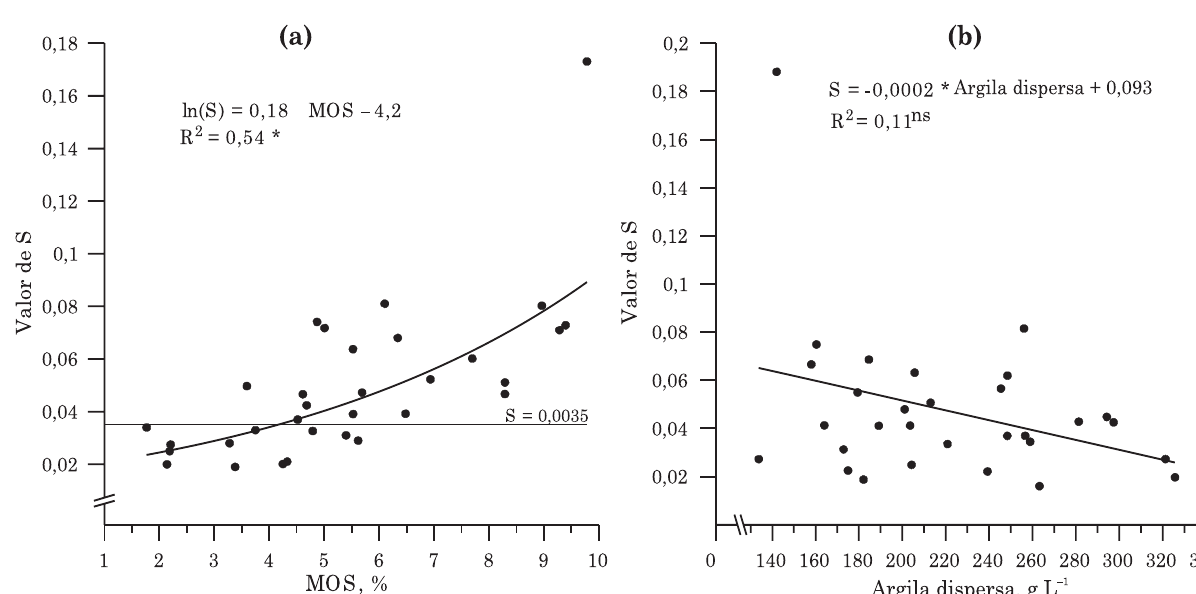
Figura 5. Comportamento do parâmetro S em função do teor de matéria orgânica (MOS, %) (a), e em função da argila dispersa (g L -1 ) dos solos (b). (* e ns: representam, respectivamente, que o modelo ajustado